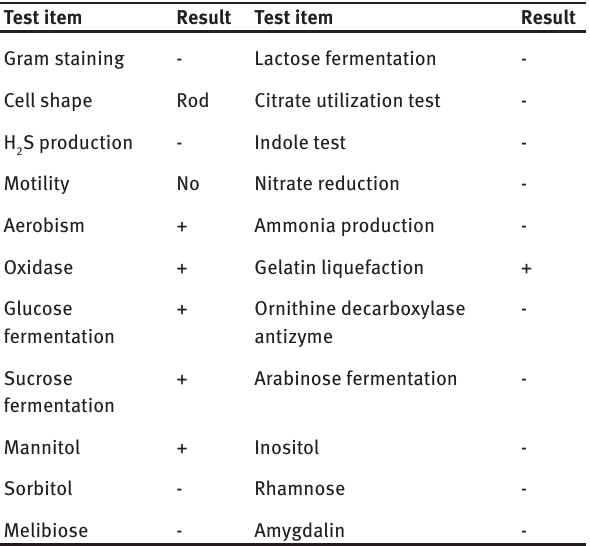
Table 1: Physiological and biochemical characteristics of strain